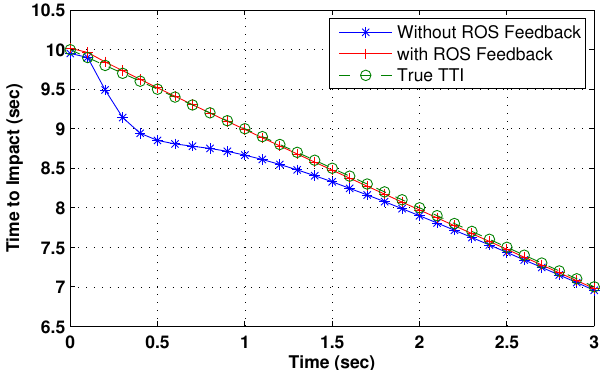
Figure 15. Estimated range-rate at targeted ship’s estimator with and without Assisted State Initialization (ASI).